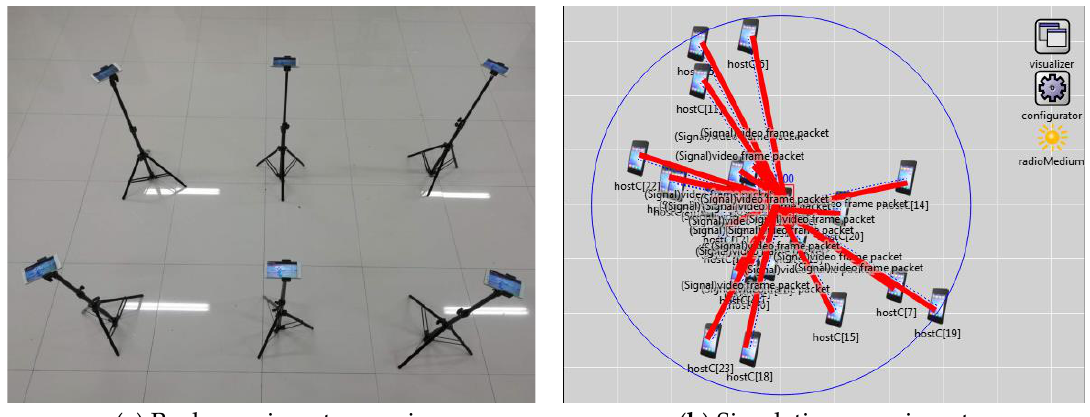
Figure 2. Experiment scenarios.